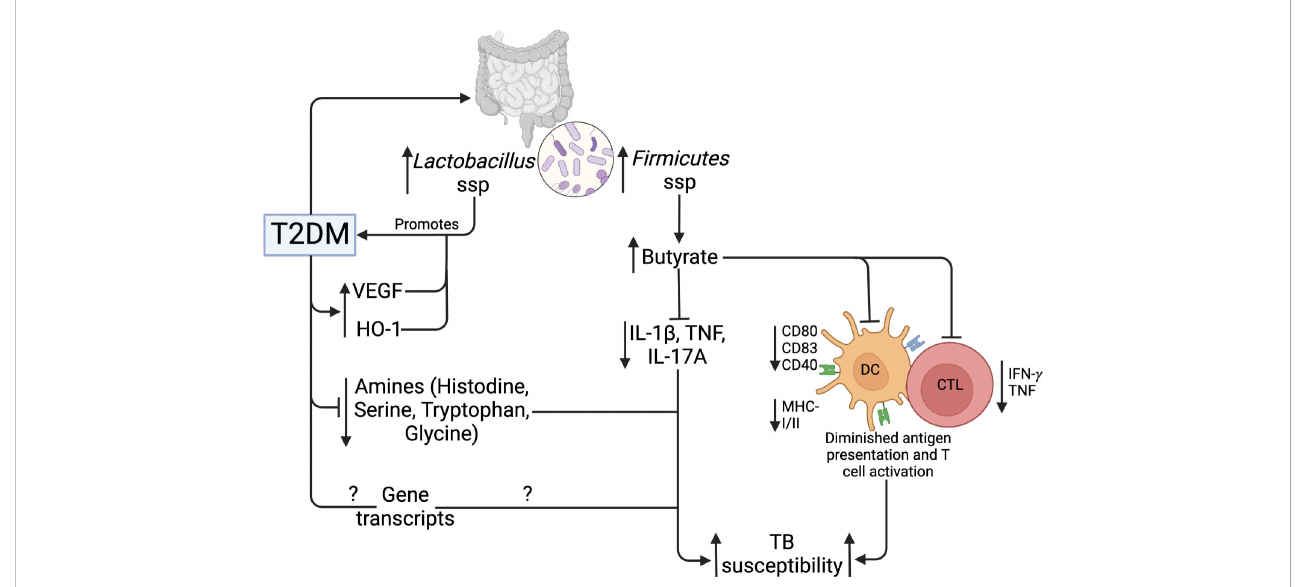
FIGURE 5 Gut microbiome, metabolic and genetic dysregulation in T2DM and TB. T2DM upregulates Lactobacillus and Firmicutes taxa of the gut microbiota. Lactobacillus promotes further T2DM development, while Firmicutes upregulate butyrate production. Butyrate inhibits Mtb -induced cytokine production, activation, and antigen presentation by DCs and CTLs. In addition, T2DM lowers speci fi c amino acids and gene transcripts. Collectively, these mechanisms increase TB susceptibility.